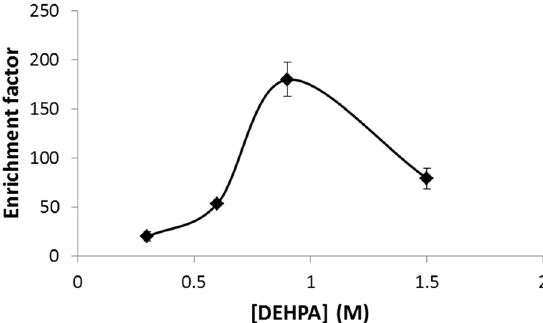
Figure 3. Effect of DEHPA concentration in the organic solution on the enrichment factor. Sample pH = 5.5, HNO 3 1.9 M. time of extraction 15 min, stirring rate 500 rpm, and electric potential 25 V.